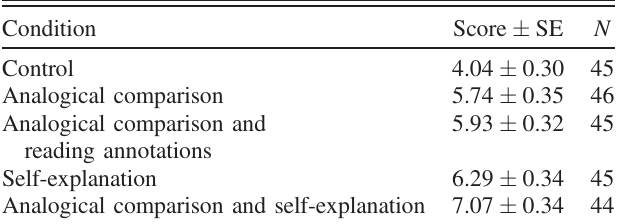
TABLE VI. Mean score on target synthesis problem out of a maximum score of 10 points by condition. Errors shown are standard